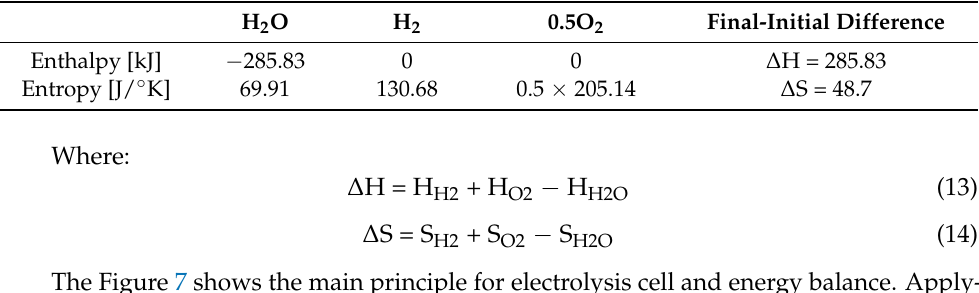
Table 1. Transformations in the electrolysis